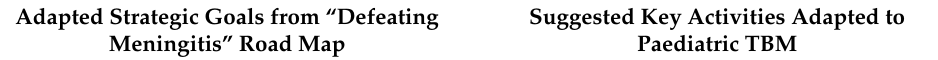
Table 2. Selected strategic goals reproduced from Pillar 1 of the “defeating meningitis” roadmap and suggested paediatric tuberculous meningitis (TBM)-related activities [4]. Adapted Strategic Goals from “Defeating Suggested Key Activities Adapted to Meningitis” Road Map Paediatric